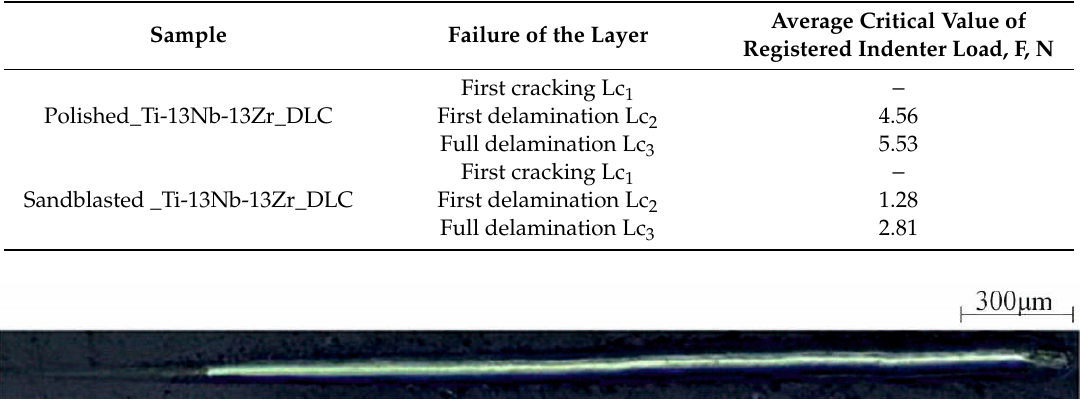
Table 3. Values of critical force L C for the evaluated variants.